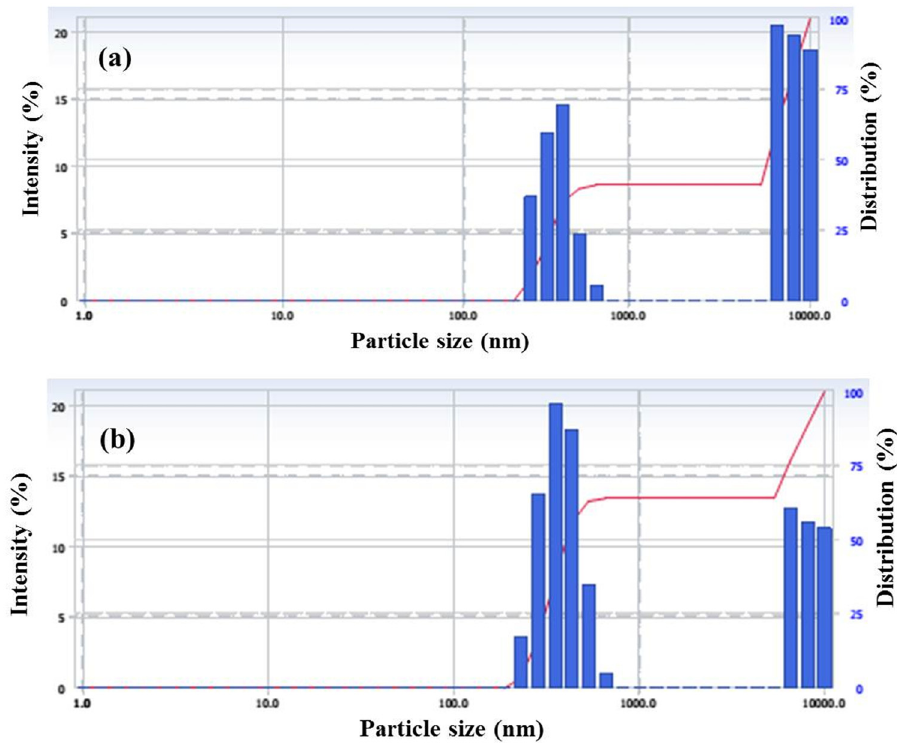
Figure A3: Particle size distribution of ( a ) AC and ( b )